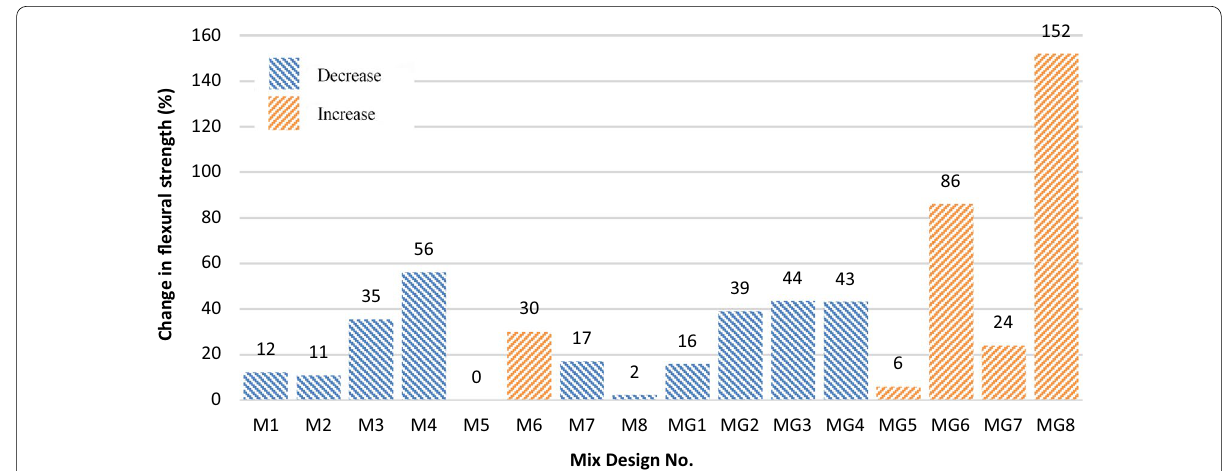
Fig. 16 Effects of GW on the residual flexural strength after